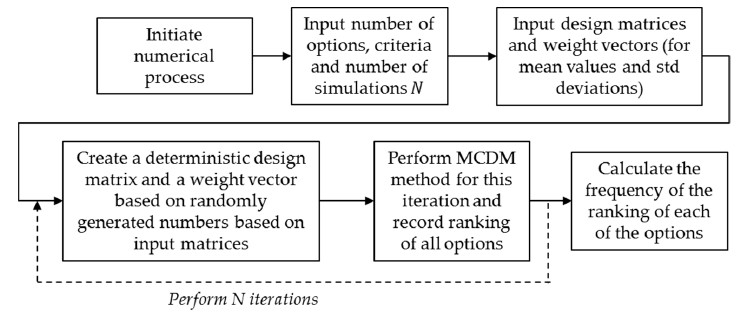
Figure 4. Stochastic expansion algorithm of deterministic MCDM methods.